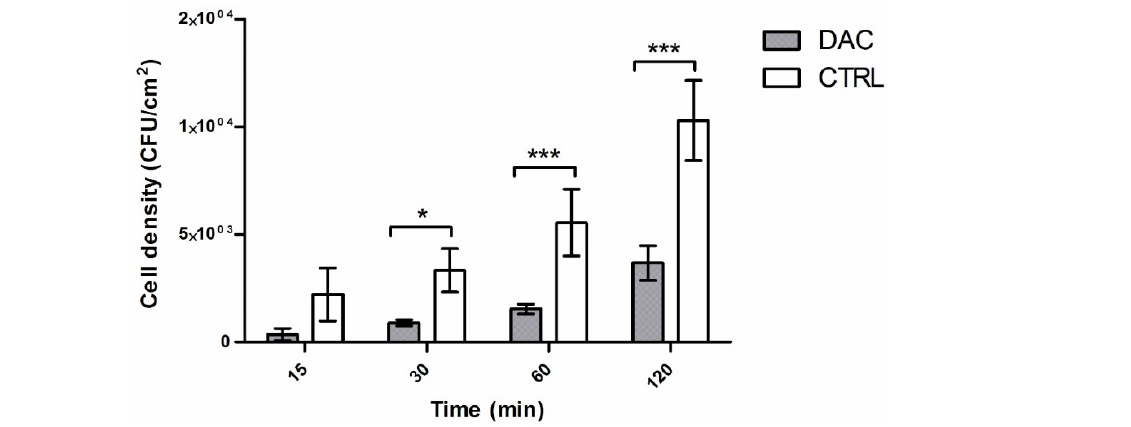
Figure 4. Adhesion densities on discs with of S. aureus ( mean CFU/cm 2 ± standard deviation ) applied before DAC treatment and controls at 15, 30, 60, 120 min; * 0.01 < P <0.05, *** P < 0.001 (two-way ANOVA followed by Bonferroni post hoc